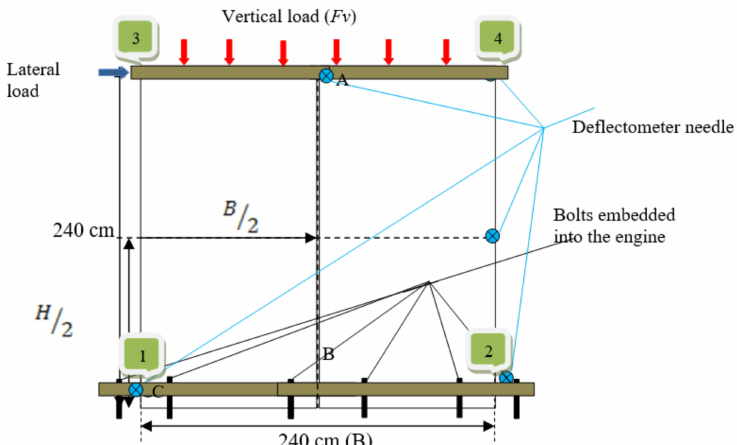
Figure 8. Shear wall mechanical strength test by racking test. 1 = Sill plate; 2 = Holddown; 3 and 4 = Steel loading fixture; A = Top plate; B = Bottom plate; C = Anchor